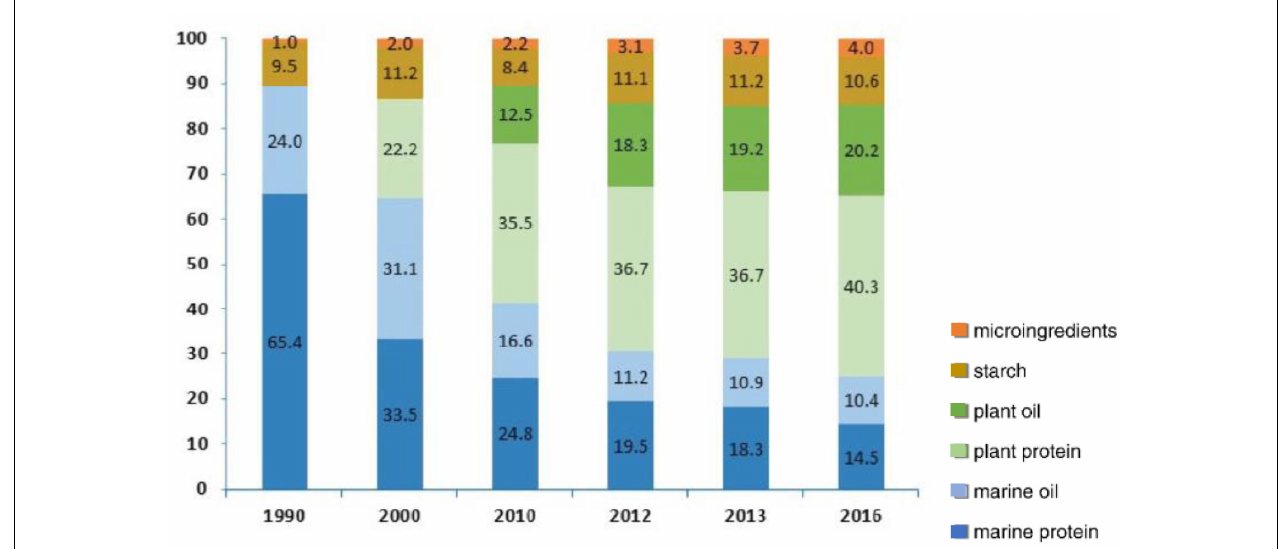
FIGURE 4 | Proportions of various ingredients in salmon feed in Norway, 1990–2016. Source: Aas et al. (2018, p. 41).